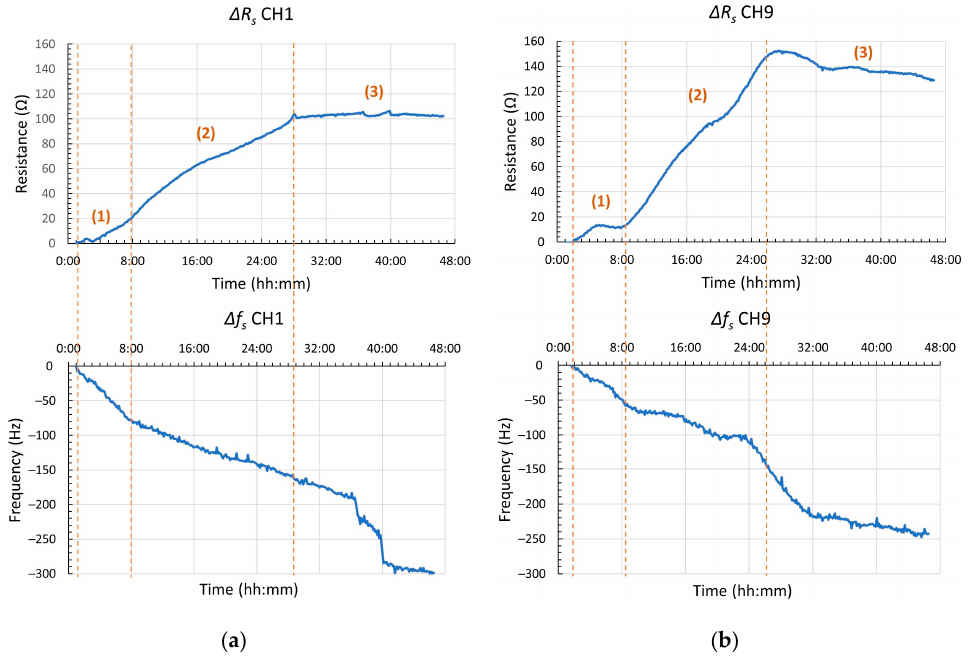
Figure 6. Resonance frequency shift, Δ f s , and resistance at resonance shift, Δ R m , in a 48-h experiment using a Staphylococcus aureus culture: ( a ) channel 1 and ( b ) channel 9. The different stages of biofilm formation and growth were identified in the graphs: ( 1 ) initial stabilization, ( 2 ) biofilm formation, and ( 3 ) maturation.